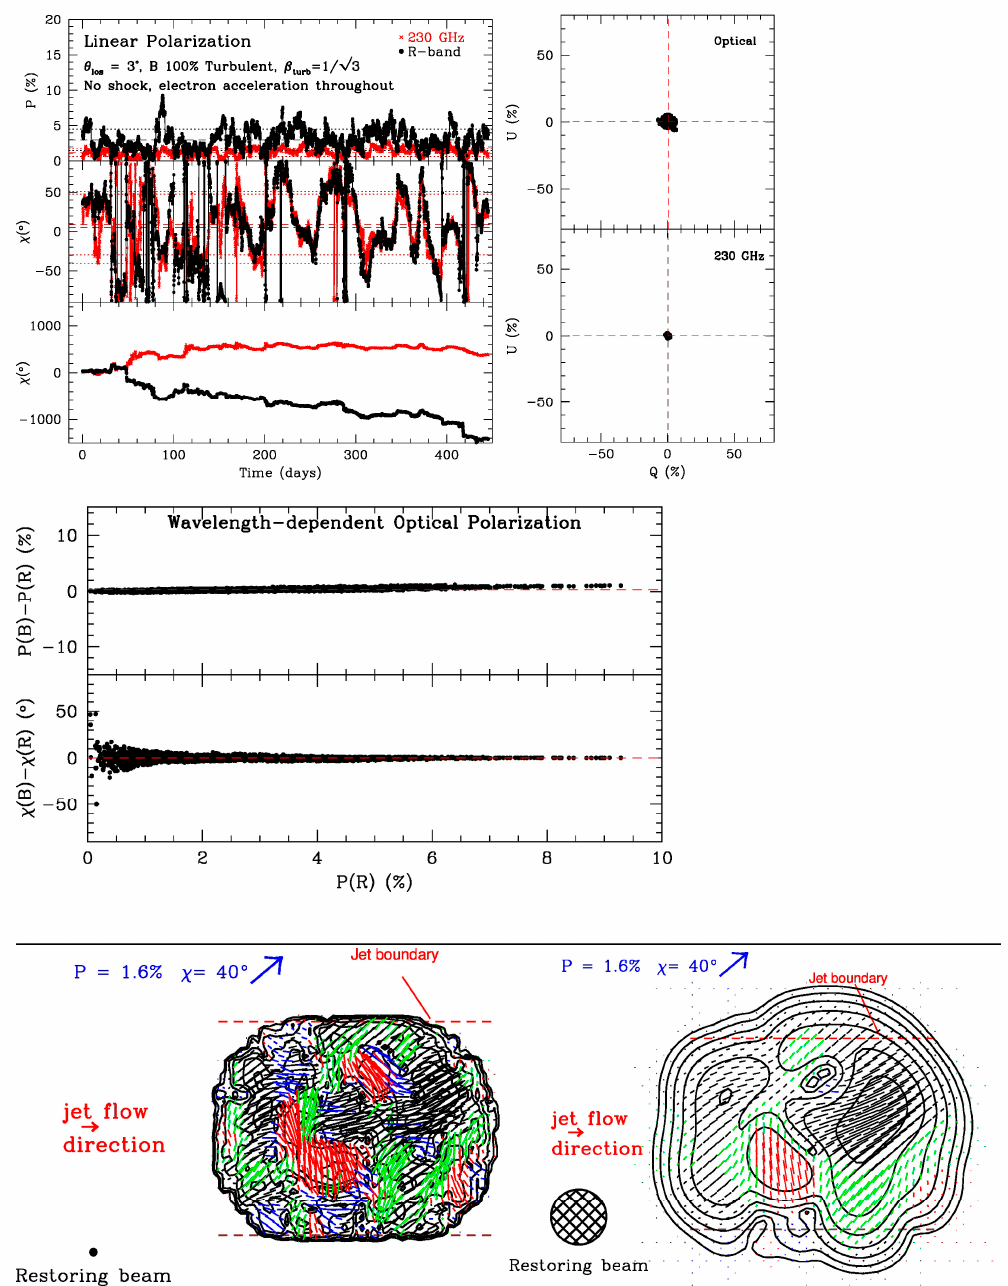
Figure 2. Simulated linear polarization behavior over 5000 time steps generated by the TEMZ model for the case of 100% turbulent magnetic field, no shock, and acceleration of electrons in each of 18,816 cells. Upper ( left ) polarization vs. time; upper ( right ) Stokes Q vs. U scatter plot; ( middle ) color-dependence (B band minus R band) of the optical polarization (dashed lines in upper right and middle plots indicate the mean values); ( bottom ) sample simulated maps of 230 GHz polarized intensity with polarization vectors superposed, convolved with circular Gaussian restoring beams of ( left ) 2 and ( right ) 20 microarcseconds FWHM, the former to show the underlying structure and the latter to approximate the resolution of VLBI at 230 GHz. In the images, the polarization vectors are color-coded according to the 45-degree-wide range in which they fall, for ease of visualization. In this and subsequent figures, β turb is the randomly directed velocity (in units of the speed of light) of the turbulent cells.